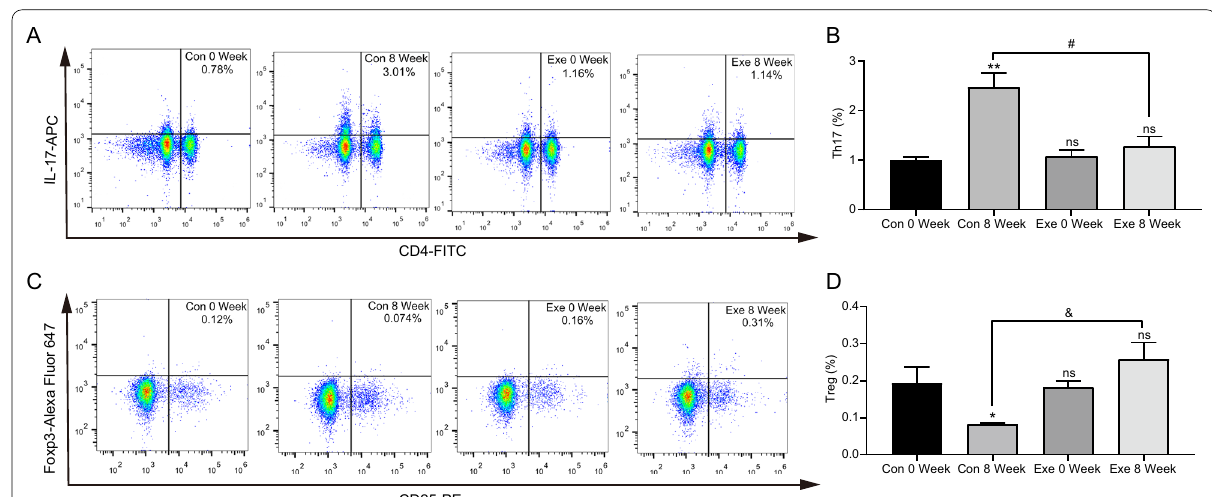
Fig. 2 Peripheral frequency of Th17/Treg in db/db mice via flow cytometry. A Representative flow cytometric plots of Th17 cells from control (Con) and exenatide (Exe) groups at week 0 and week 8. B Statistical analysis of the percentage of Th17 cells in control and exenatide groups. C Representative flow cytometric plots of Treg cells with CD4-FITC, CD25-PE and Foxp3 staining. D Statistical analysis of the percentage of Treg cells. Data are presented as mean SEM; n 8 in each group; ** P < 0.01, * P < 0.05 vs control 0 week; & P < 0.01, # P < 0.05 vs control 8 week; ns P > ± =